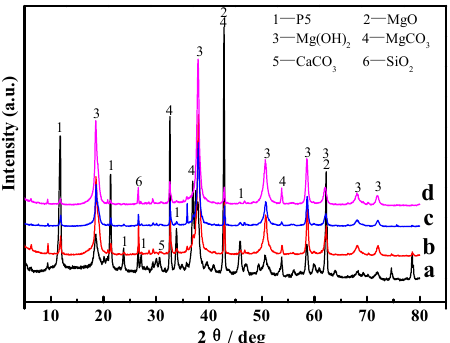
Figure 10. XRD patterns of the surface layers of the MOC samples after different dry–wet cycles: (a) without dry–wet cycles; (b) one time; (c) two times; (d) three times.